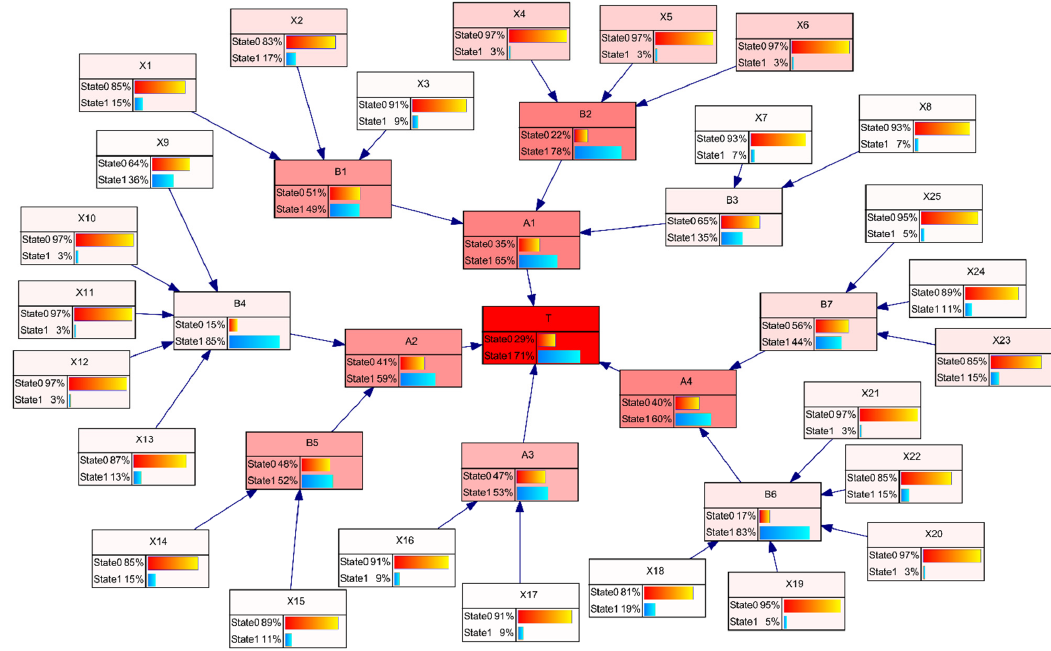
Figure 6. Results of sensitivity analysis on BFG leakage accidents.